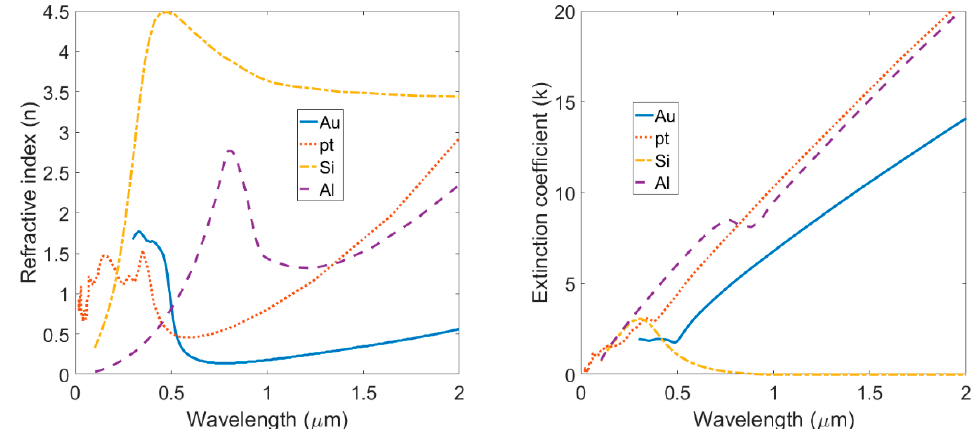
Figure 1. Refractive and extinction coefficients of some materials as function of wavelength.